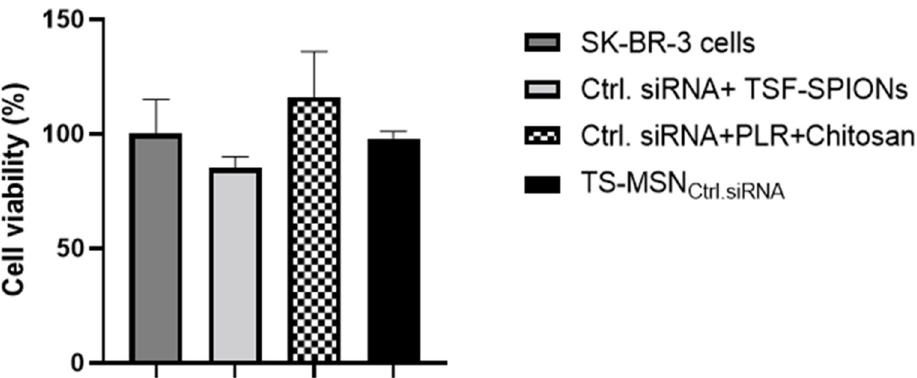
Figure 8. Cell viability of the SK-BR-3 cell line treated either with a mixture of control (Ctrl.) siRNA and TSF-SPIONs, a mixture of Ctrl. siRNA, poly-l-arginine (PLR), and chitosan, or TS-MSN ctrl. siRNA . Data are presented as the mean ± SD. TS-MSN: Targeted stealth magnetic siRNA nanovectors, TSF-SPIONs: targeted stealth fluorescent superparamagnetic iron oxide nanoparticles.